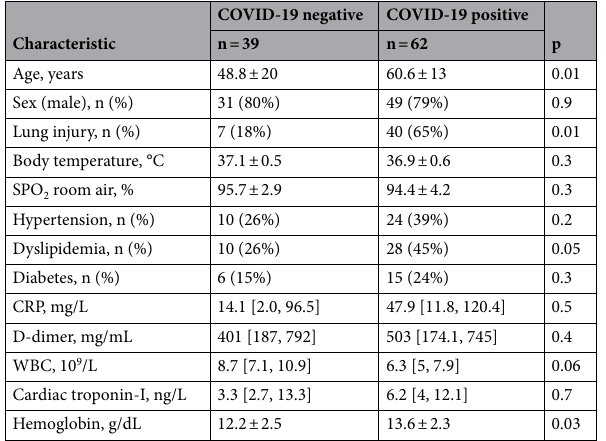
Table 1. Patient characteristics. Values are presented as mean ± SD, or median [interquartile range] for irregularly distributed parameters. Blood test results were taken from the day of imaging (n = 78). CRP C-reactive protein, WBC white blood count, SPO 2 saturation of peripheral oxygen. P values by two-tailed unpaired t-test, non-parametric Mann-Whitney test, and Chi-square